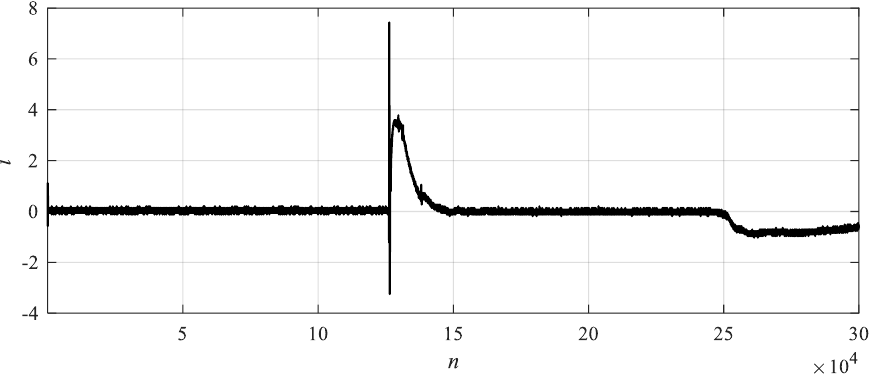
Figure 5. The sampled current vector i .